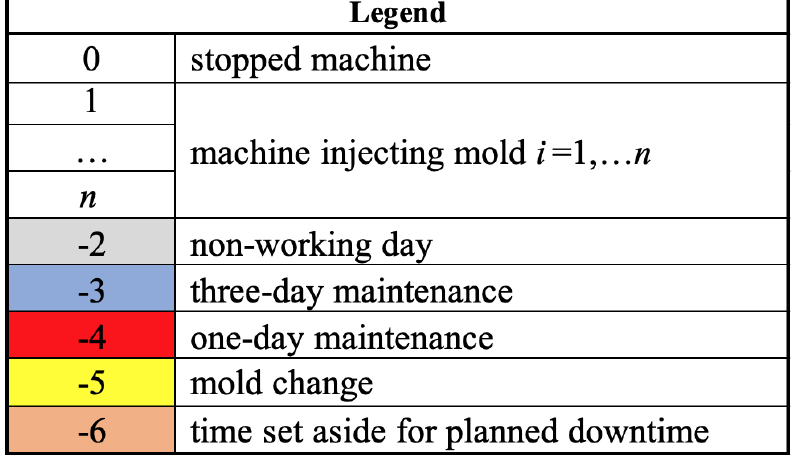
Figure 1. Solution